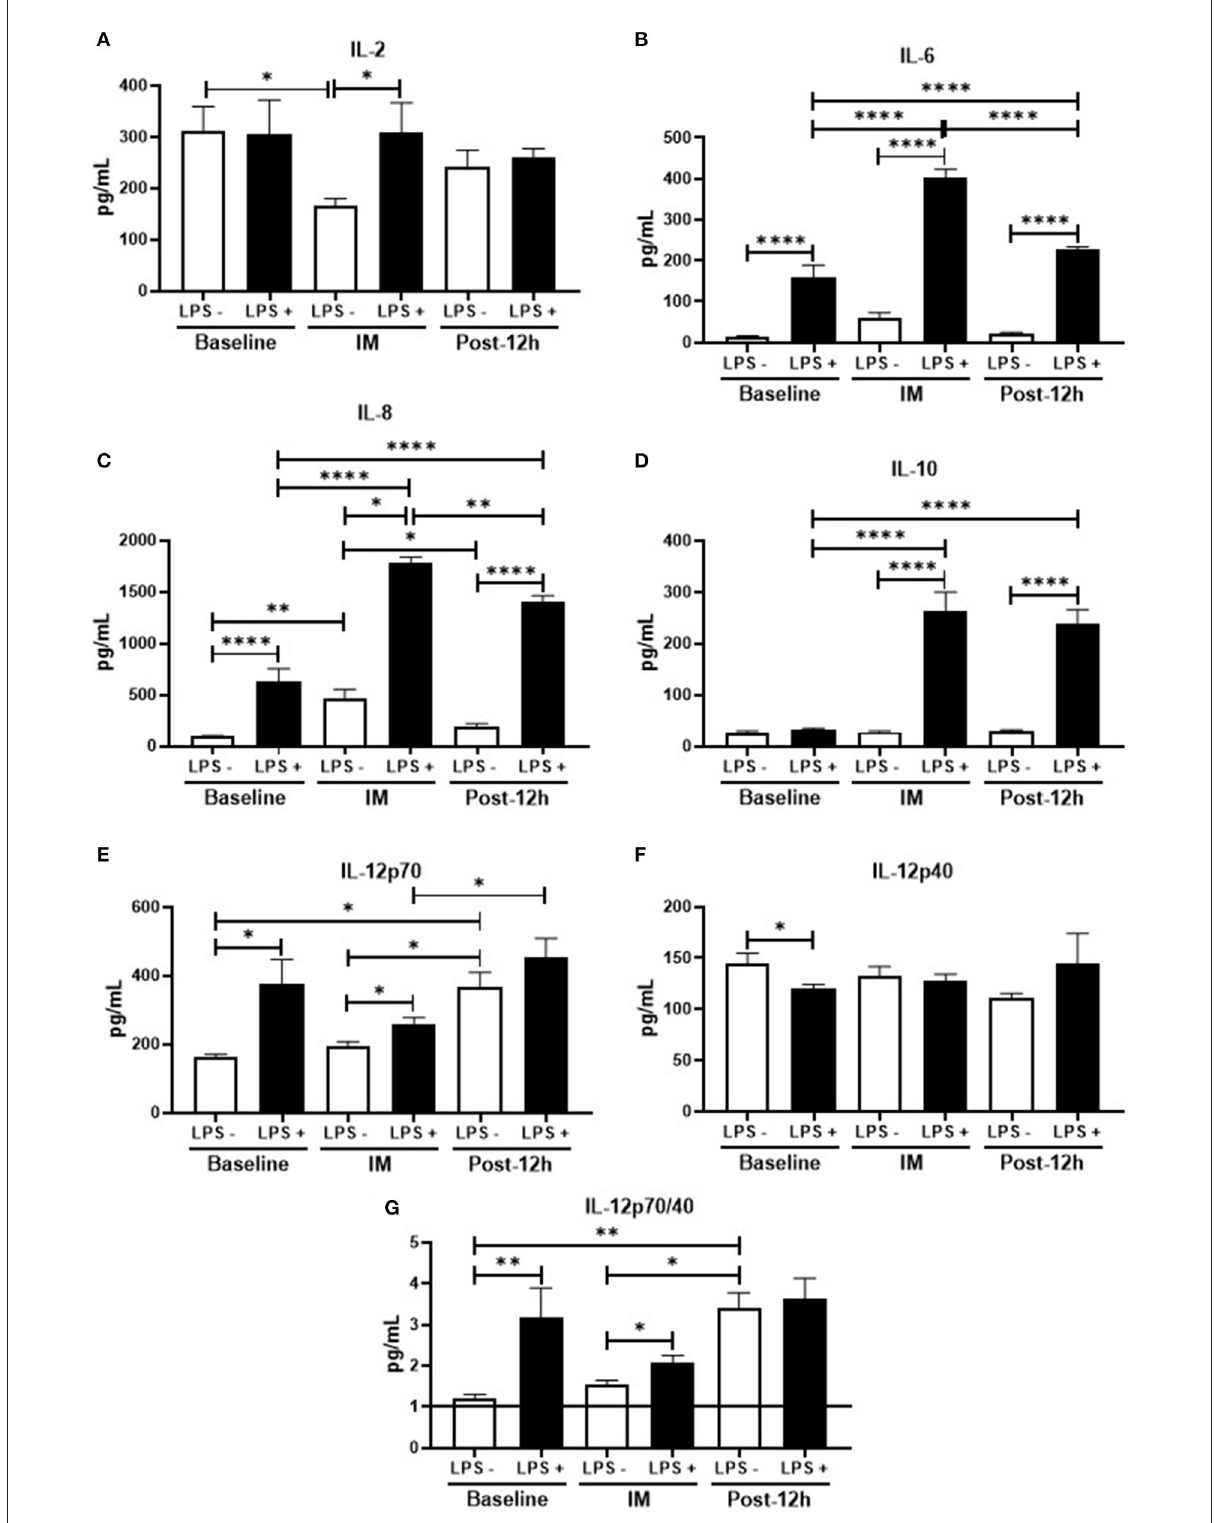
FIGURE3 (A–G) Profile of inflammatory and non-inflammatory cytokines at the time-points, in LPS + and LPS − : * p < 0.05, ** p < 0.01, *** p < 0.001, **** p <